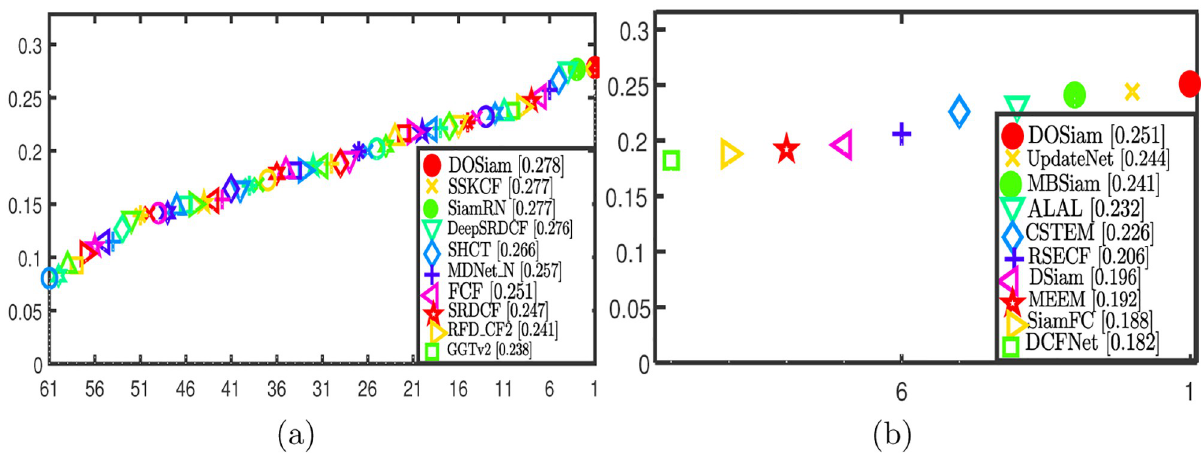
Fig 9. A comparison of the DOSiam with state-of-the-art trackers in terms of success rate and precision on VOT2016 and VOT2018 with different attributes, respectively.